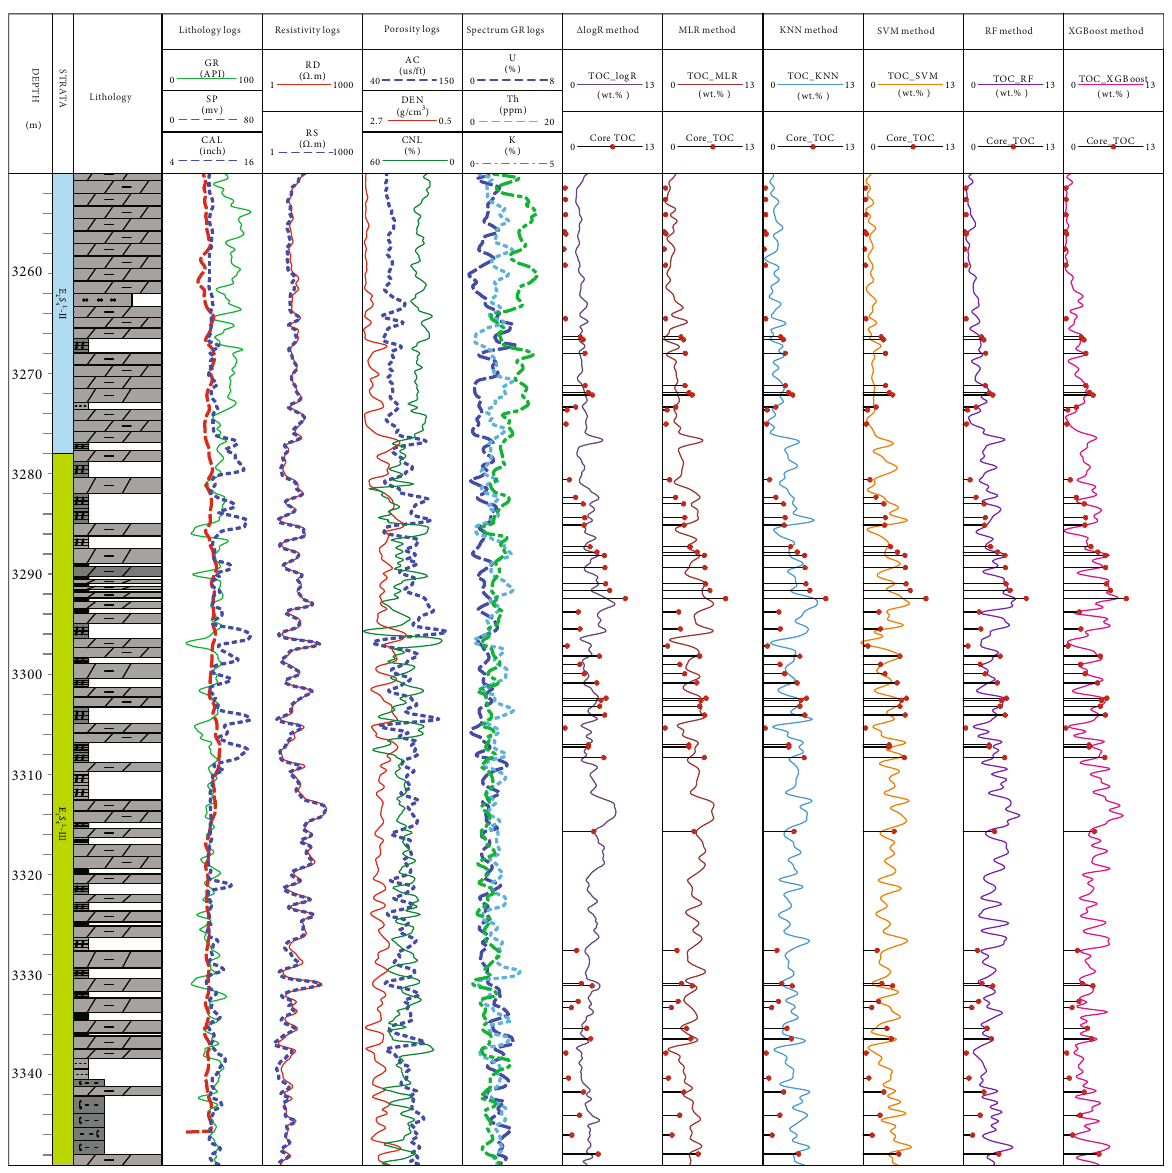
Figure 11: Comparison of prediction results by di ff erent methods (E